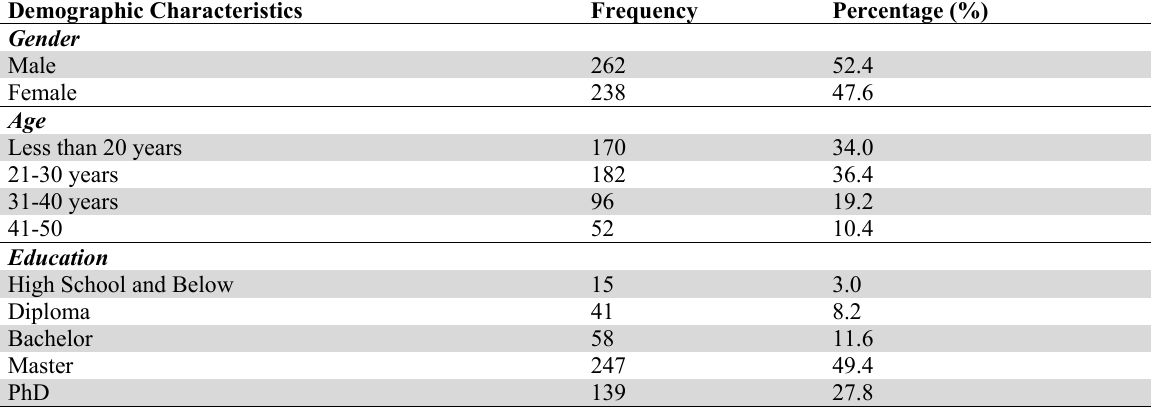
Demographic Profile of the Respondents